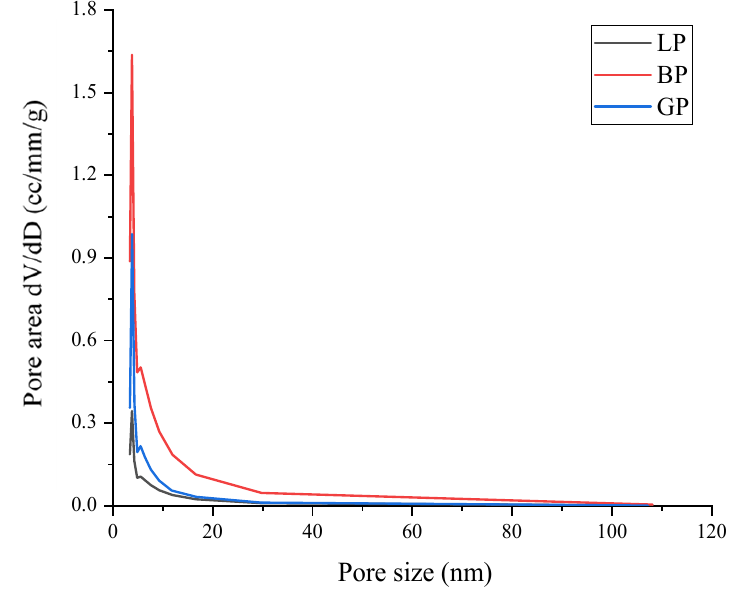
Figure 4. Pore size distribution of mineral powders by BET. Table 7. Physical parameters of mineral powders.